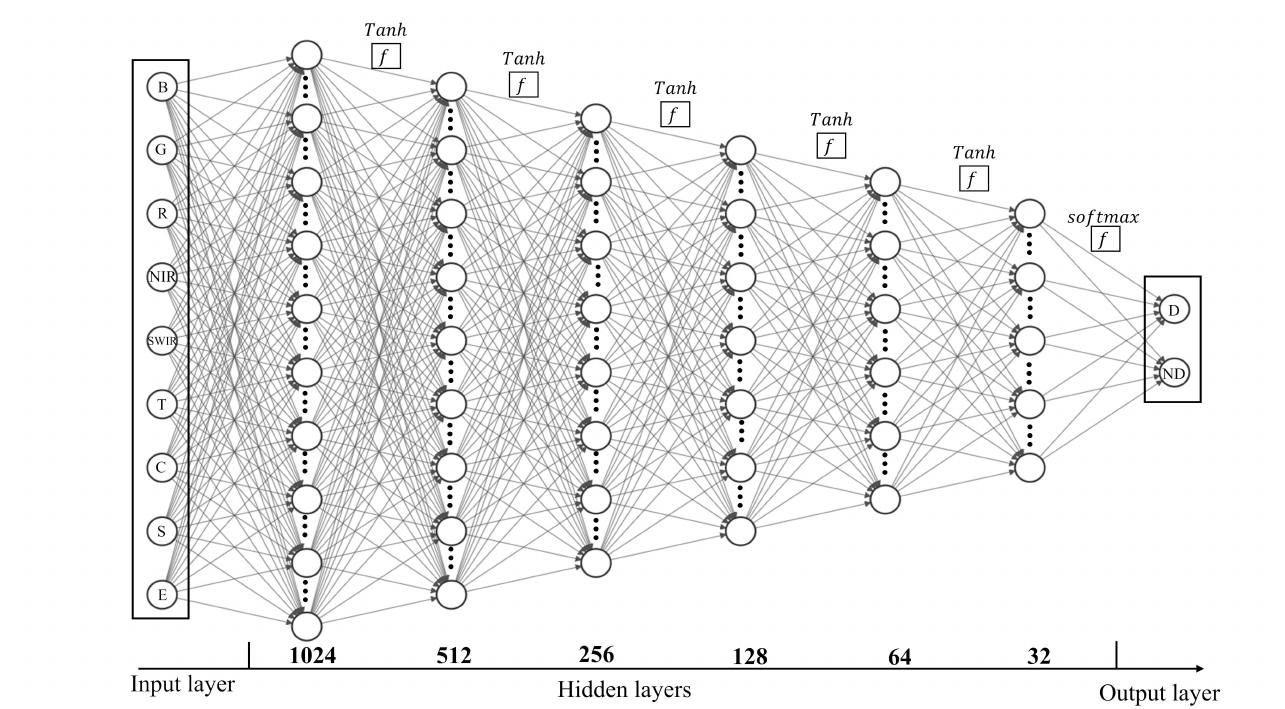
Figure 2. Deep learning neural network (DNN) architecture used for delineation of supraglacial debris (SGDNet). The numbers indicate the total number of unit (i.e., neurons) in each layer. The input layer consists of 9 bands (B: blue, G: green, R: red, NIR: near-infrared, SWIR: shortwave infrared, T: thermal, C: coherence, S: slope, and E: elevation). The output of the developed DNN is D: debris or ND: